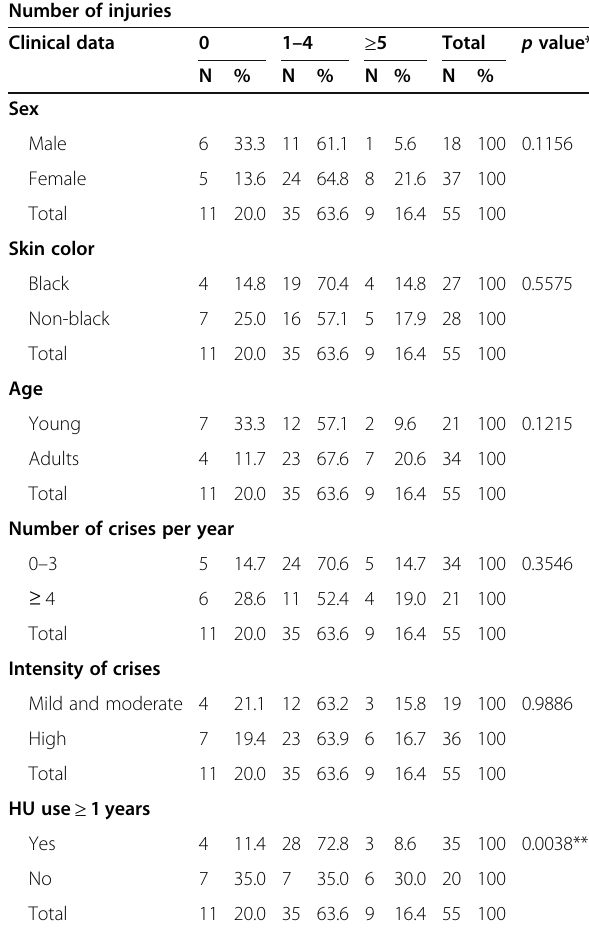
Table 3 Evaluation of the number of lesions according to epidemiological and clinical characteristics Number of injuries Clinical